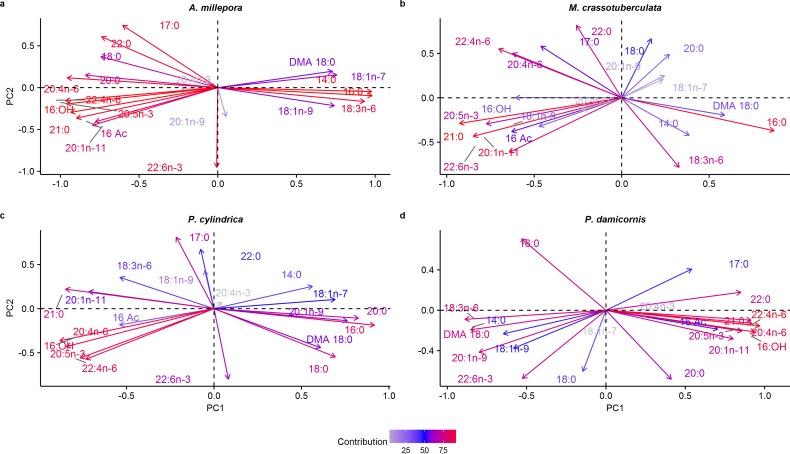
Principal component analysis loading plot of fatty acid and fatty alcohol profiles of denuded skeleton and isolated tissue of four scleractinian species prepared with the air-spraying method (% fatty acids).Colour gradient shows percentage contribution to overall variance. Fatty alcohol abbreviations: 16 Ac, Hexadecyl acetate; DMA, 18:0, 1,1-dimethoxyoctadecane; 16:OH, 1-hexadecanol.